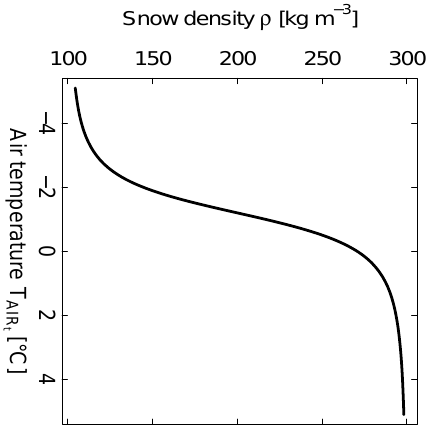
Figure 3. Estimation of the density of snow using Eqs. (8) and (9). Minimum and maximum densities of fresh snow are 100 and 300kgm − 3 ,